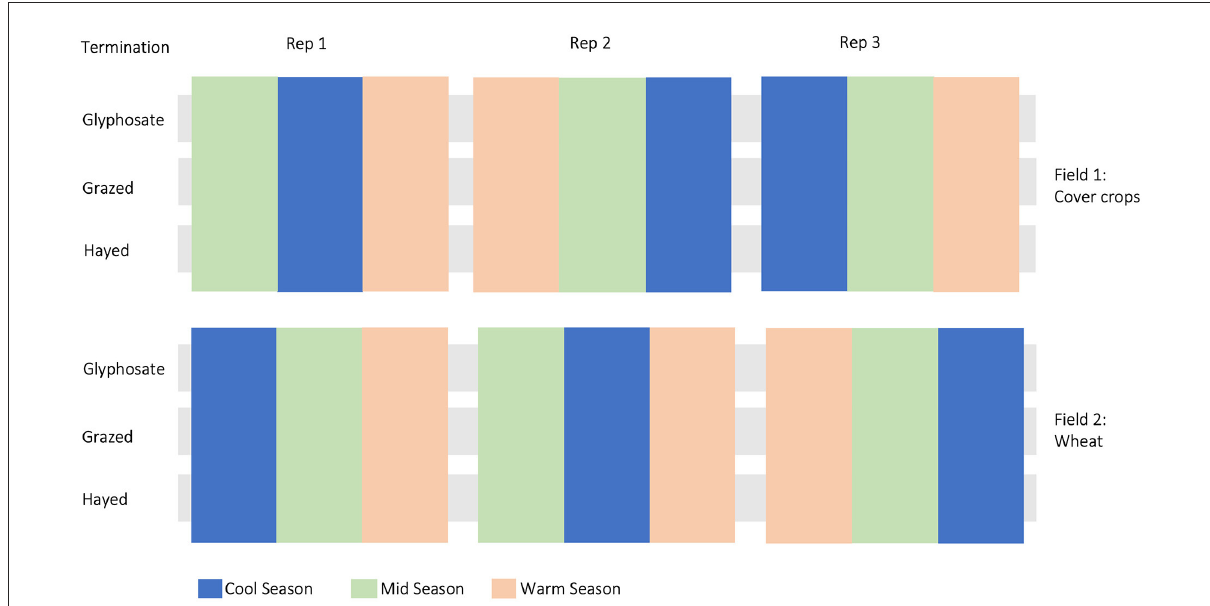
FIGURE1 Study design showing randomized treatments (colored bars) and cover crop termination treatments (gray strips). Cover crops and wheat were rotated each year between field 1 and 2. Plot dimensions were 7.3m x 40.2m with a 3.6m wide buffer strip between each plot. Plots are not drawn to